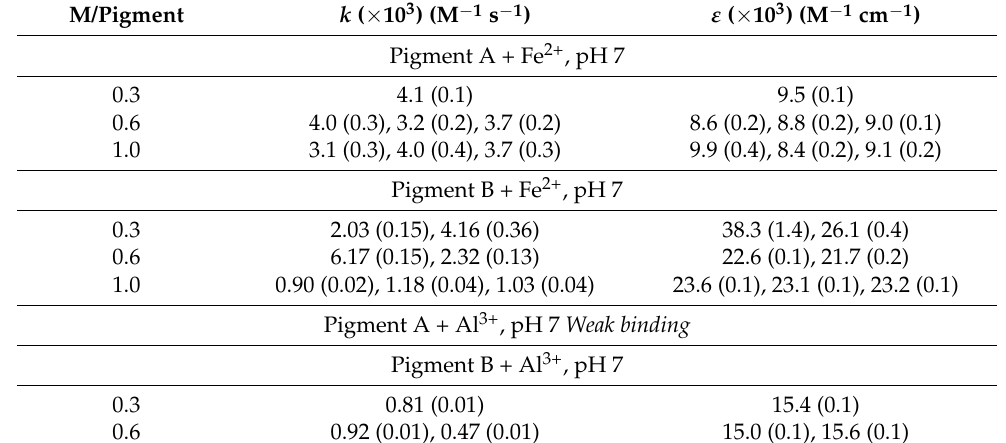
Table 3. Kinetic analyses of metal–anthocyanin binding according to the stepwise formation of ML, ML 2 , and ML 3 complexes (25 ◦ C, monitoring at 670 nm). ML n : metal–ligand complex having a 1:n metal/ligand stoichiometry. For simplicity, the successive binding steps are described by rate constants 3 k , 2 k, and k , respectively, and each bound ligand by the same molar absorption coefficient ε . Some repetitions are shown. Values between brackets are standard deviations for the curve-fitting